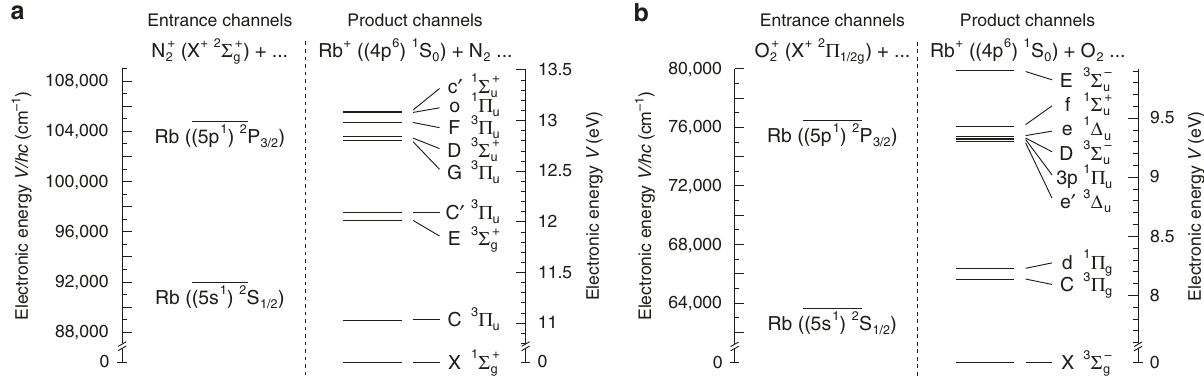
+ Rb and b O þ + Rb CT 2 2